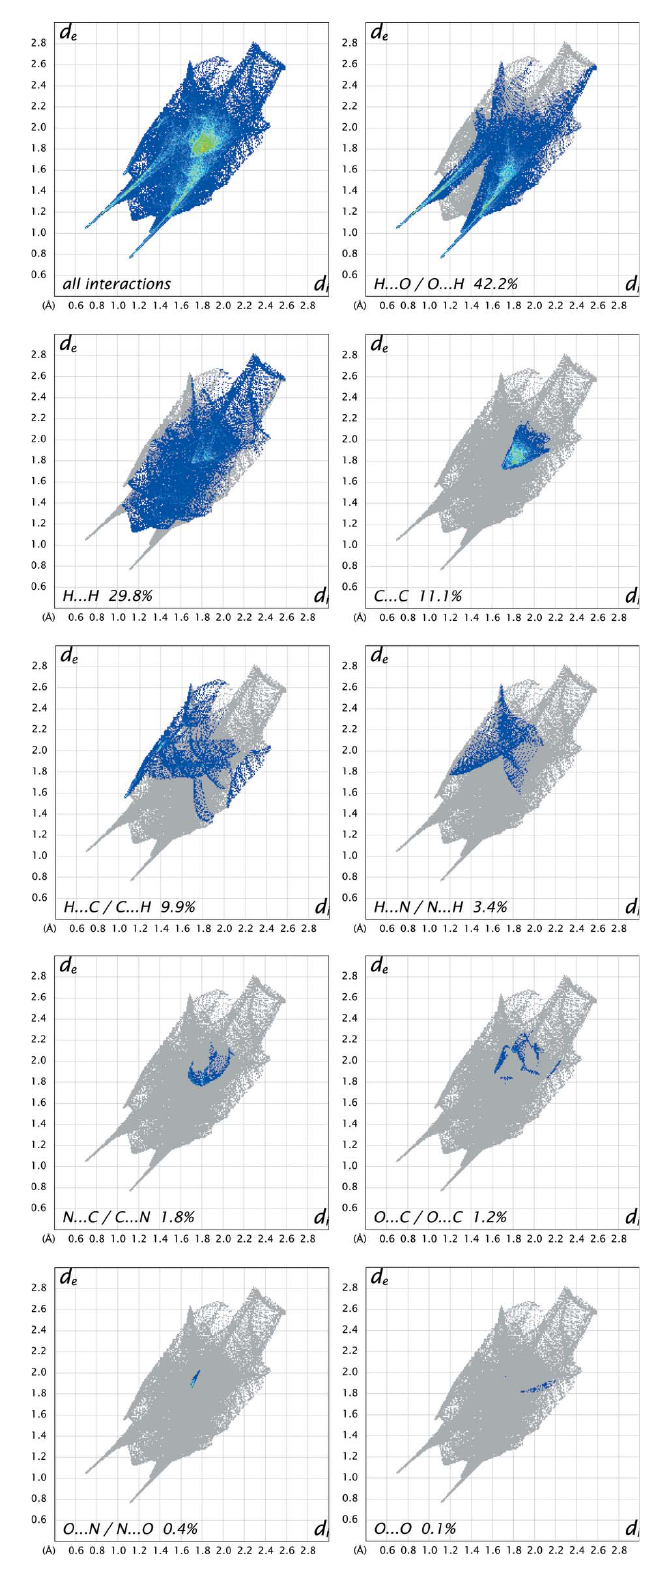
Figure 11 The full two-dimensional fingerprint plots for the N , N 0 -(1,4-phenyl- enedicarbonyl)diglycine solvent molecule, showing all interactions, and delineated into the contributions from different contacts. The d i and d e values are the closest internal and external distances (in A˚ ) from given points on the Hirshfeld surface